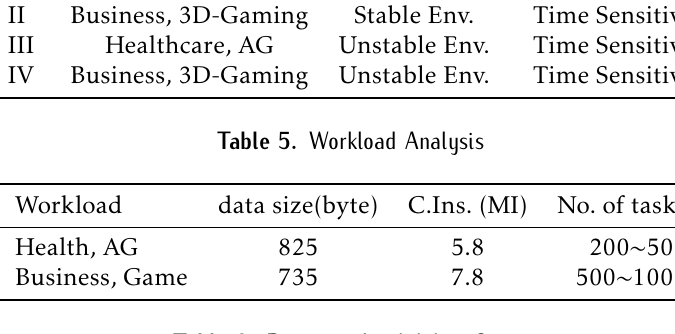
Table 6. Resource Availability Cases